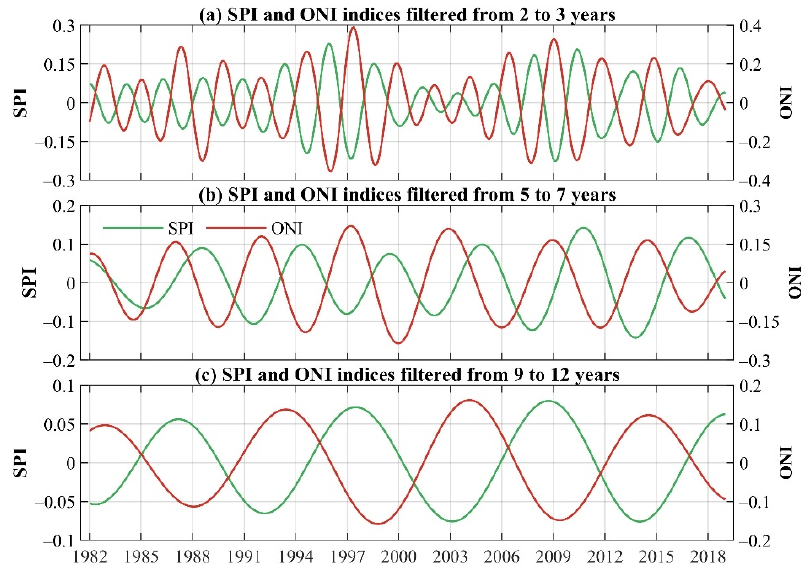
Figure 5. ( a ) Cross ‐ wavelet spectra (XWT), as well as ( b ) wavelet coherence (WTC) and phase dif ‐ ferences between the oceanic Niño index (ONI) and PC1 of the monthly SPI. Closed contours rep ‐ resent the squared wavelet coherence. The region where the edge effects were significant is under the U ‐ shaped curve (the cone of influence). High XWT values indicate more common frequency features; high WTC values reveal a stronger relationship between the two time series in time frequency. Additionally, arrows indicate the phase differences as follows: in ‐ phase (0°), pointing to the right; out of phase (180°), pointing to the left; the first time series leading the second by 90°, pointing down; and the first time series lagging the second by 90°, pointing upwards.